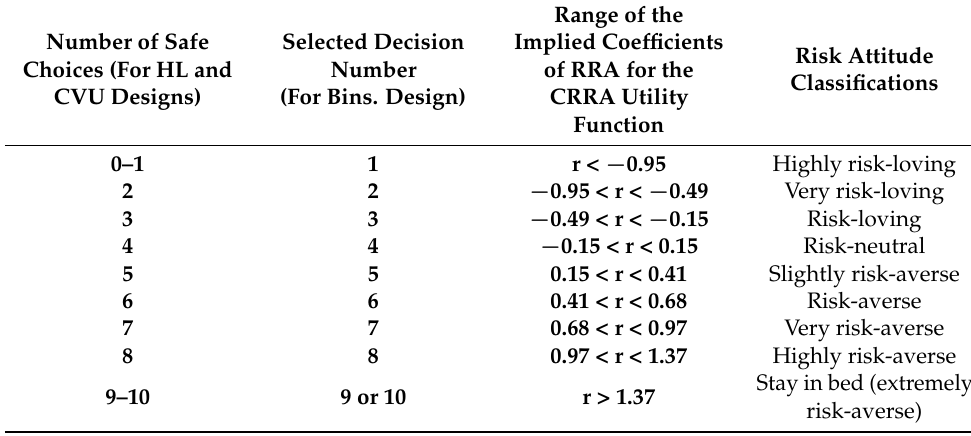
Figure A9. Individual lottery choice decisions—Session A. Table A10. Risk aversion classifications based on chosen options.